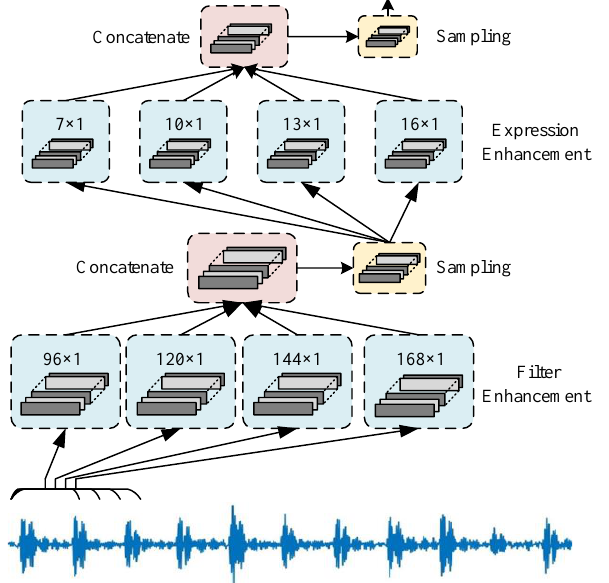
Figure 3. The structure of the enhanced integrated filter. K × 1 represents the sizes of the convolution kernel. Concatenate stands for feature fusion. Sampling represents using the pooling layer.